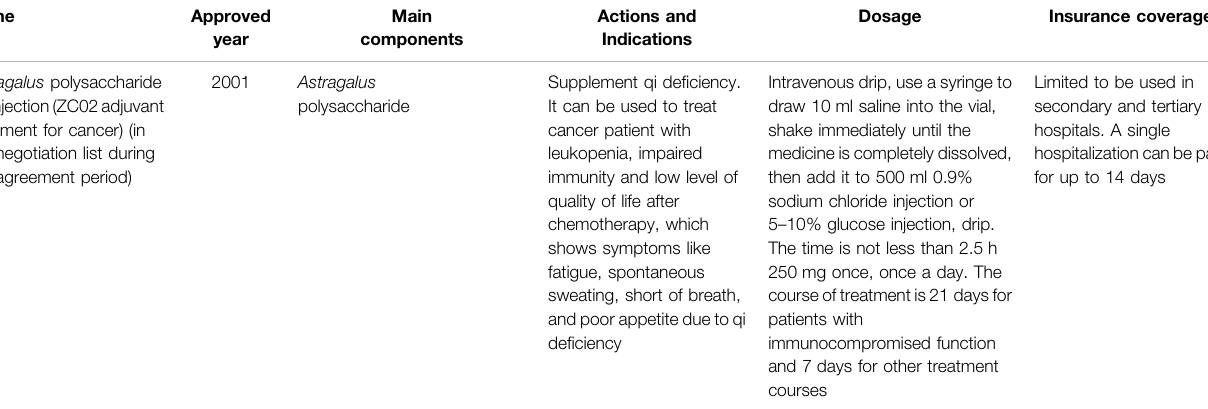
Supplementary Table S1 . According to the classi fi cation of the health insurance catalog, six injections were de fi ned as ZC01 anti- cancer drugs, and four were ZC02 adjuvant drugs for cancer.